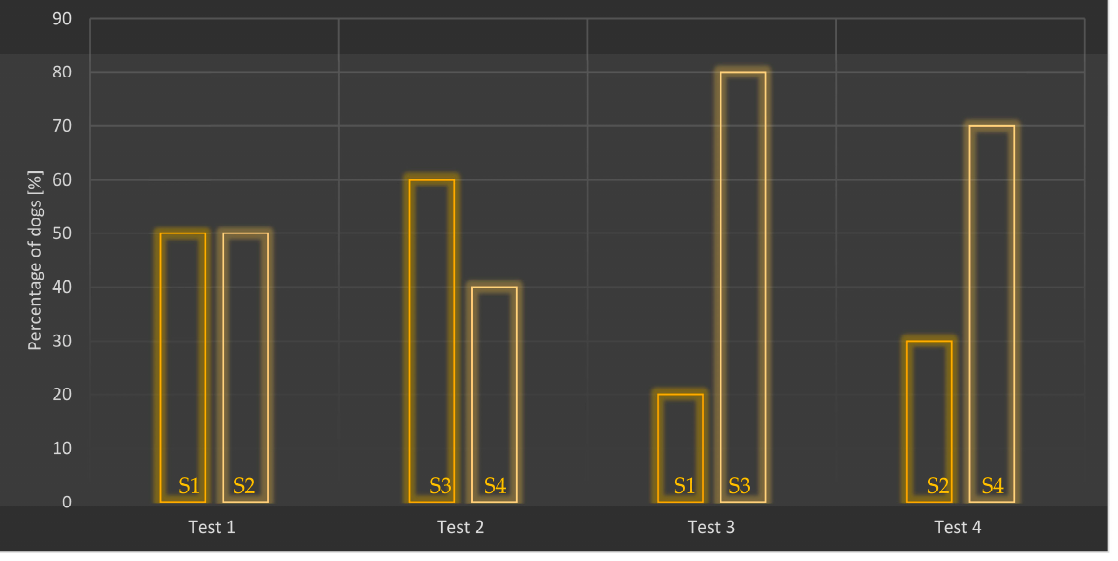
Figure 6 . Dog preferences in four palatability tests. Figure 6. Dog preferences in four palatability